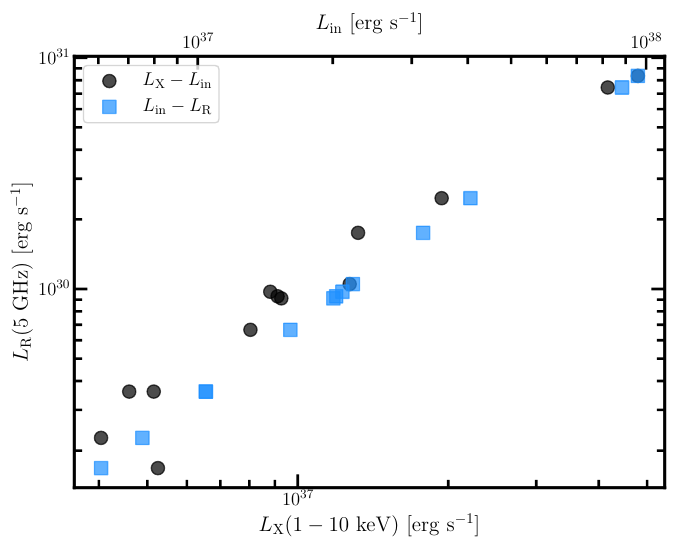
Figure 3. Radio/X-ray correlation for the ‘outlier’ track of H1743-322 (in the upper x-axis, the inner- disk luminosity is L in ). The black circles represent the observed radio/X-ray correlation, while the blue squares represent the radio/inner-disk correlation where the inner-disk luminosity is calculated using Equations (4) and